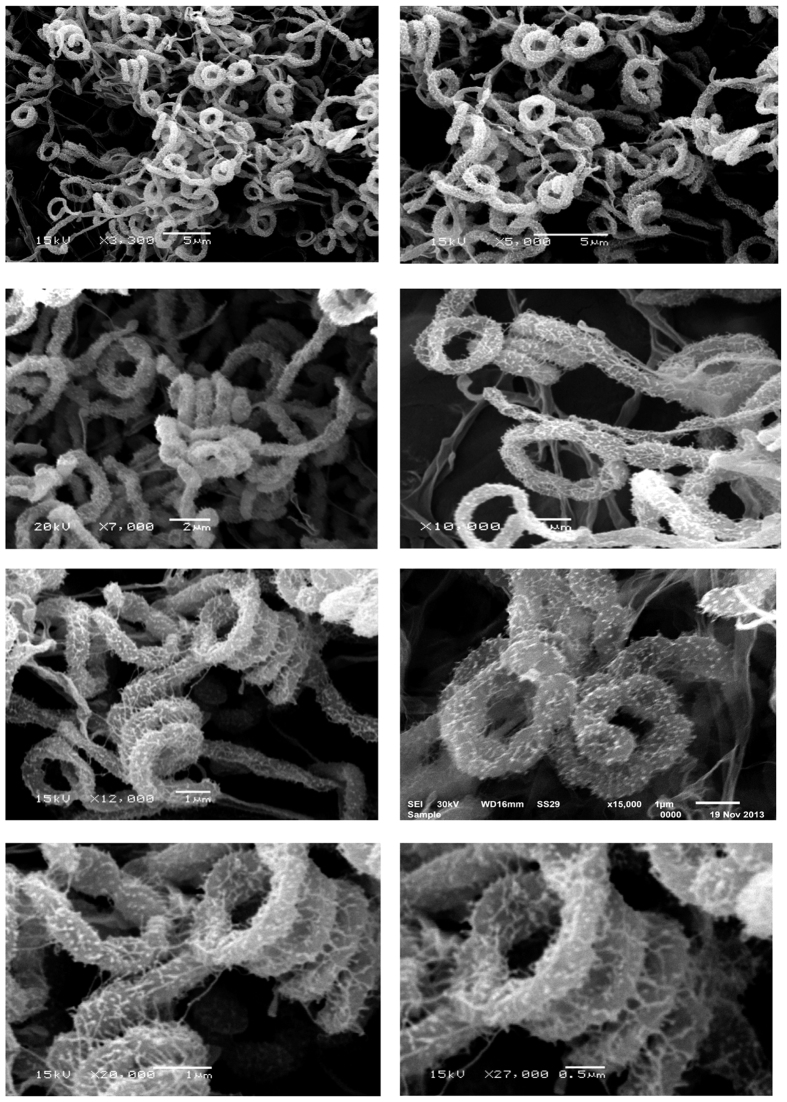
Scanning electron micrograph showing the spore-chain morphology and spore-surface ornamentation of strain NEAE -H grown on starch nitrate agar medium for 14 days at 30 °C at different magnification.